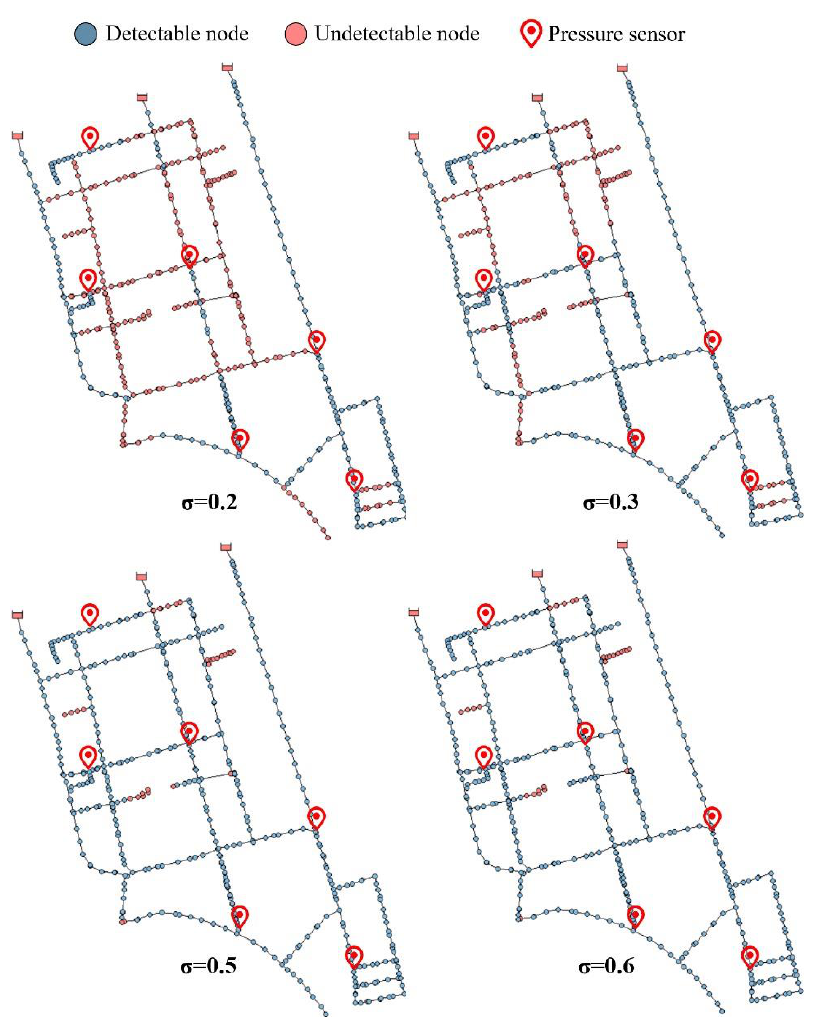
Figure 11. Detection results of six pressure sensors under average flow conditions.